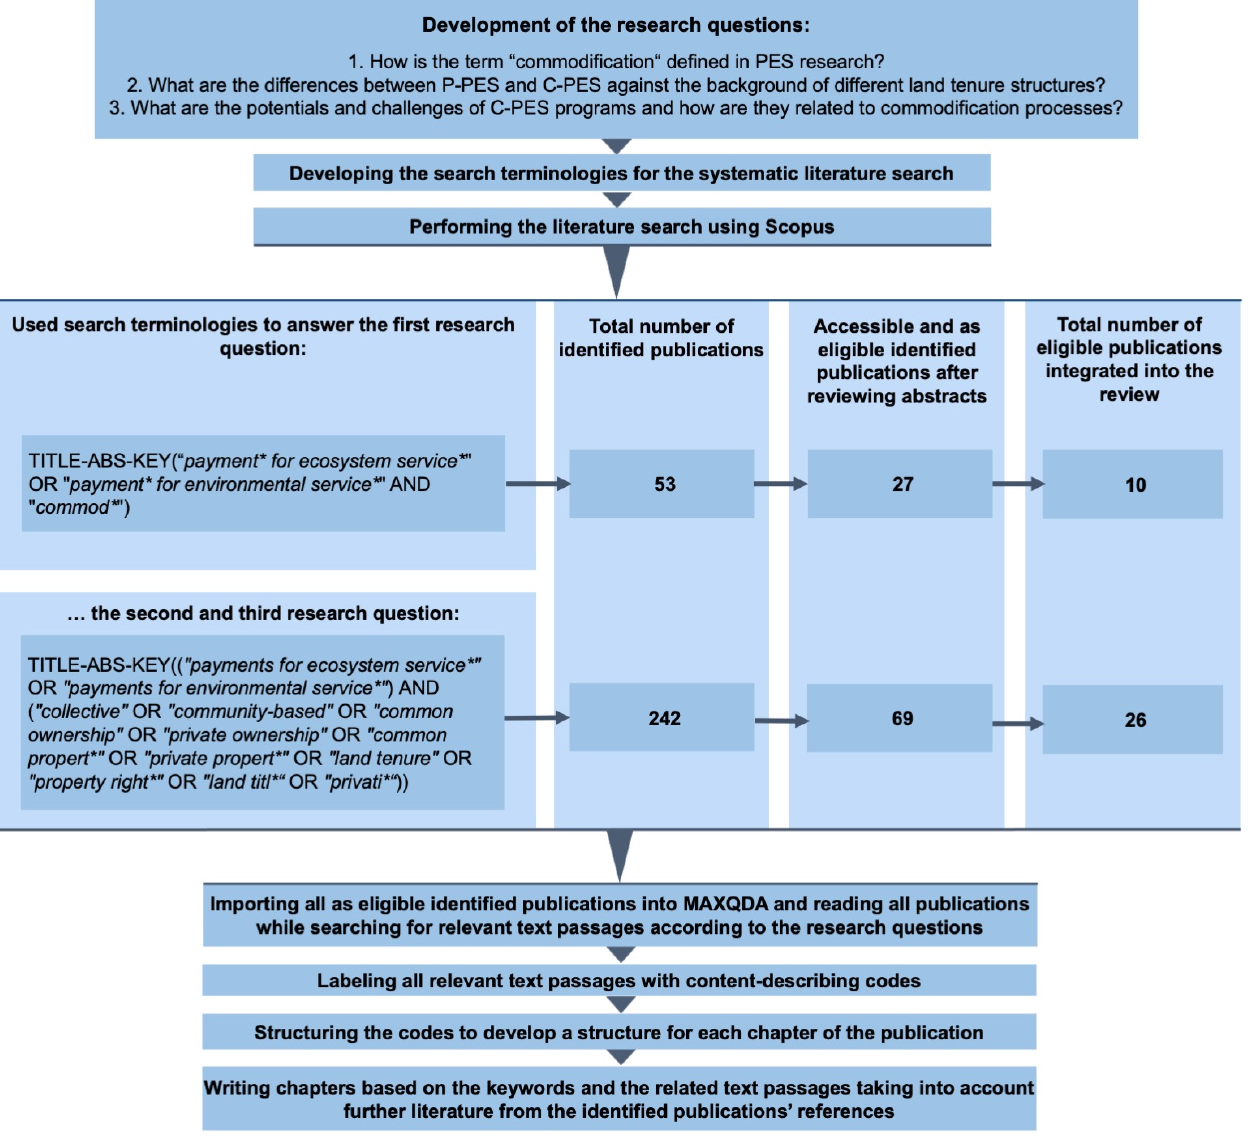
Fig. 1. Methodological steps of this study and quantitative results of the literature review. PES = payments for ecosystem services; P-PES = private-individual PES; C-PES = community-based or collective